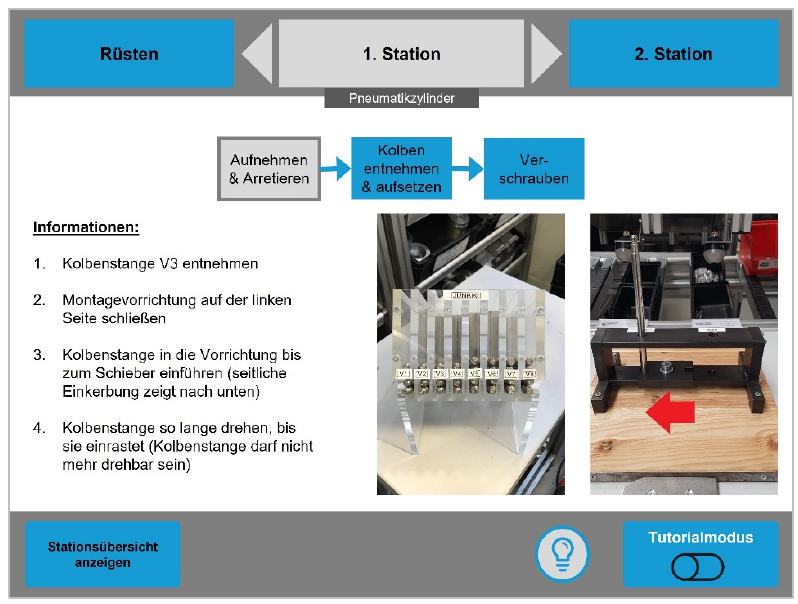
Figure 4. Comparison system that was used by the control group in the study.